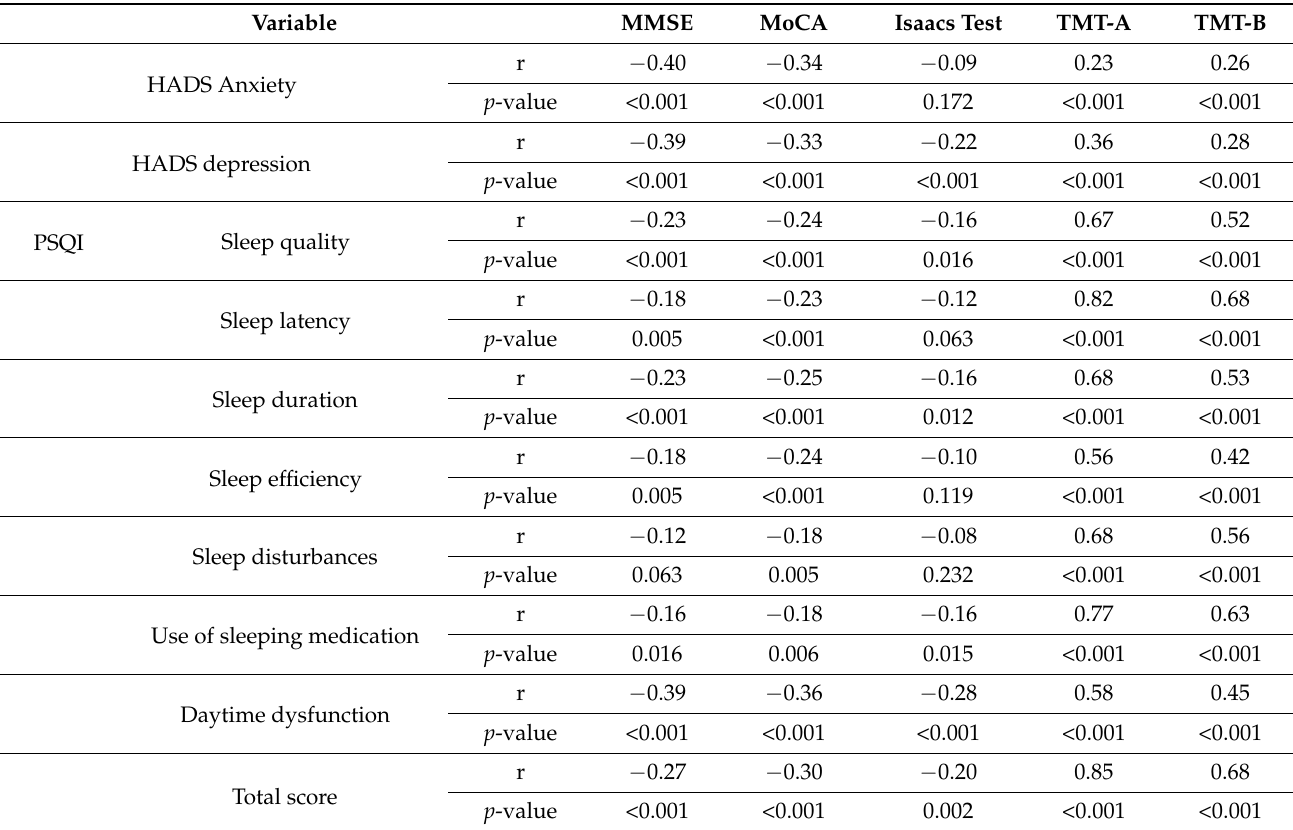
Table 3. Partial correlations between cognitive outcomes and anxiety, depression, sleep quality controlled for age. Variable MMSE MoCA HADS Anxiety